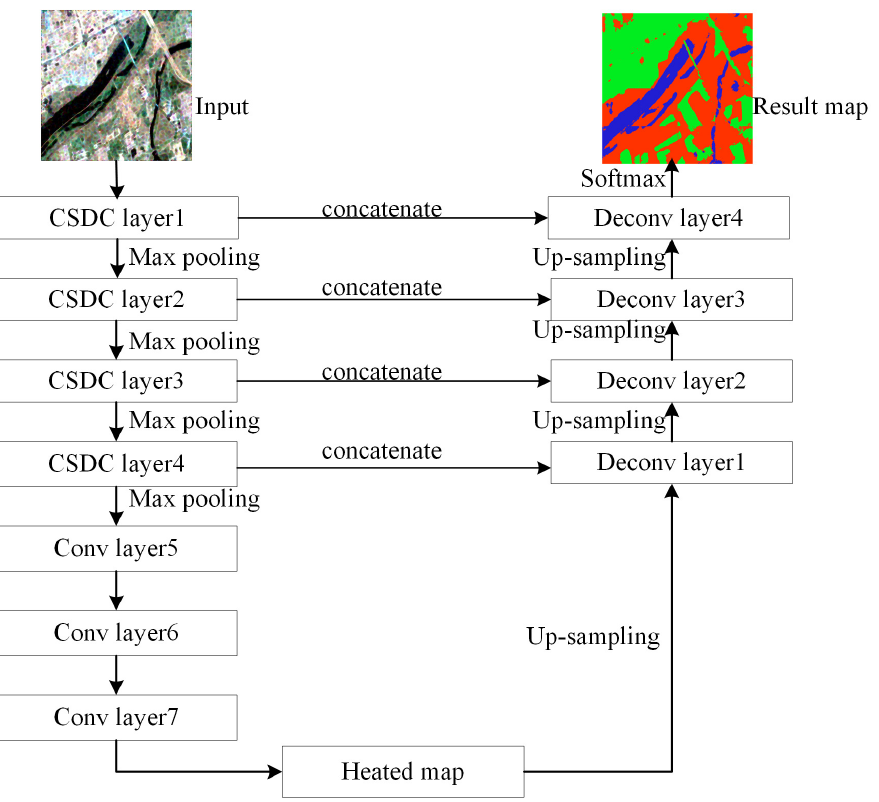
Figure 4. The overall framework of the proposed